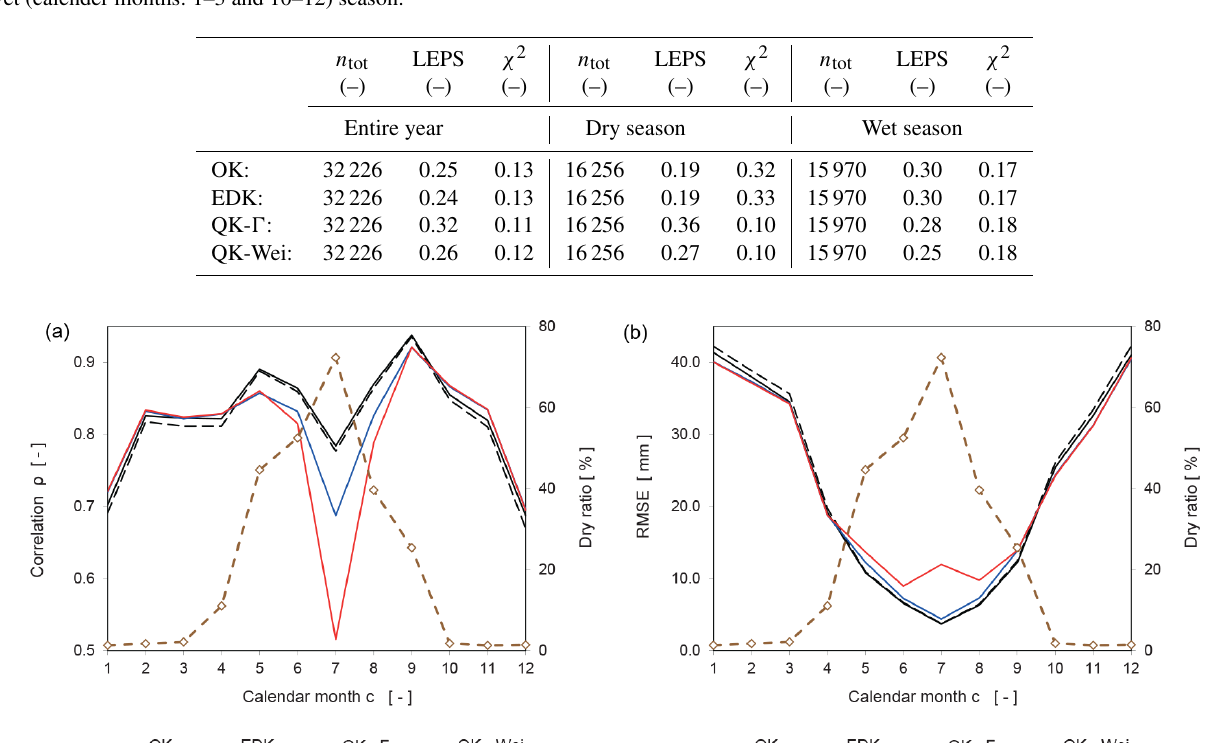
Table 2. Summary results from the cross-validation of the estimation error for the entire year, and split into dry (calender months: 4–9) and wet (calender months: 1–3 and 10–12) season.